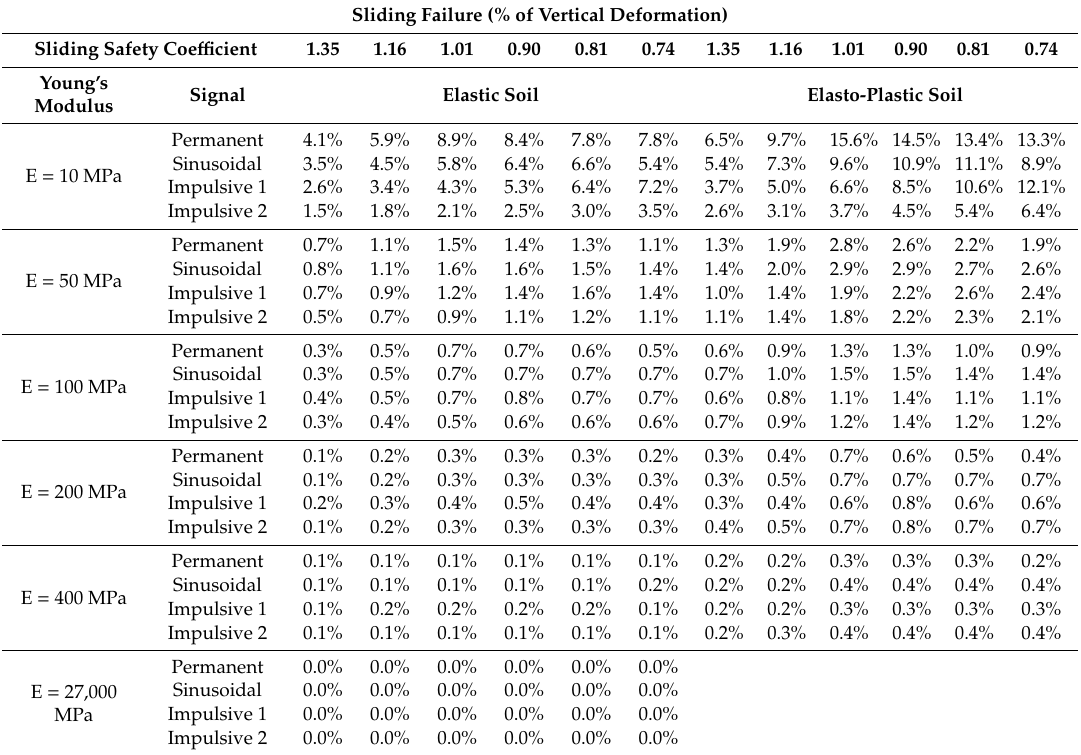
Table 7. Vertical deformation in simulations under load state B. Sliding Failure (% of Vertical